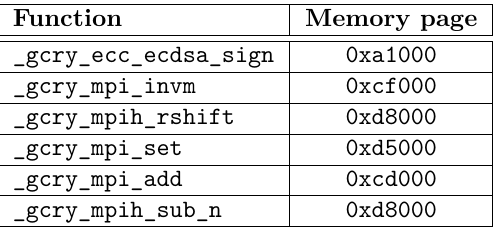
Table 2: Tracked functions and their memory